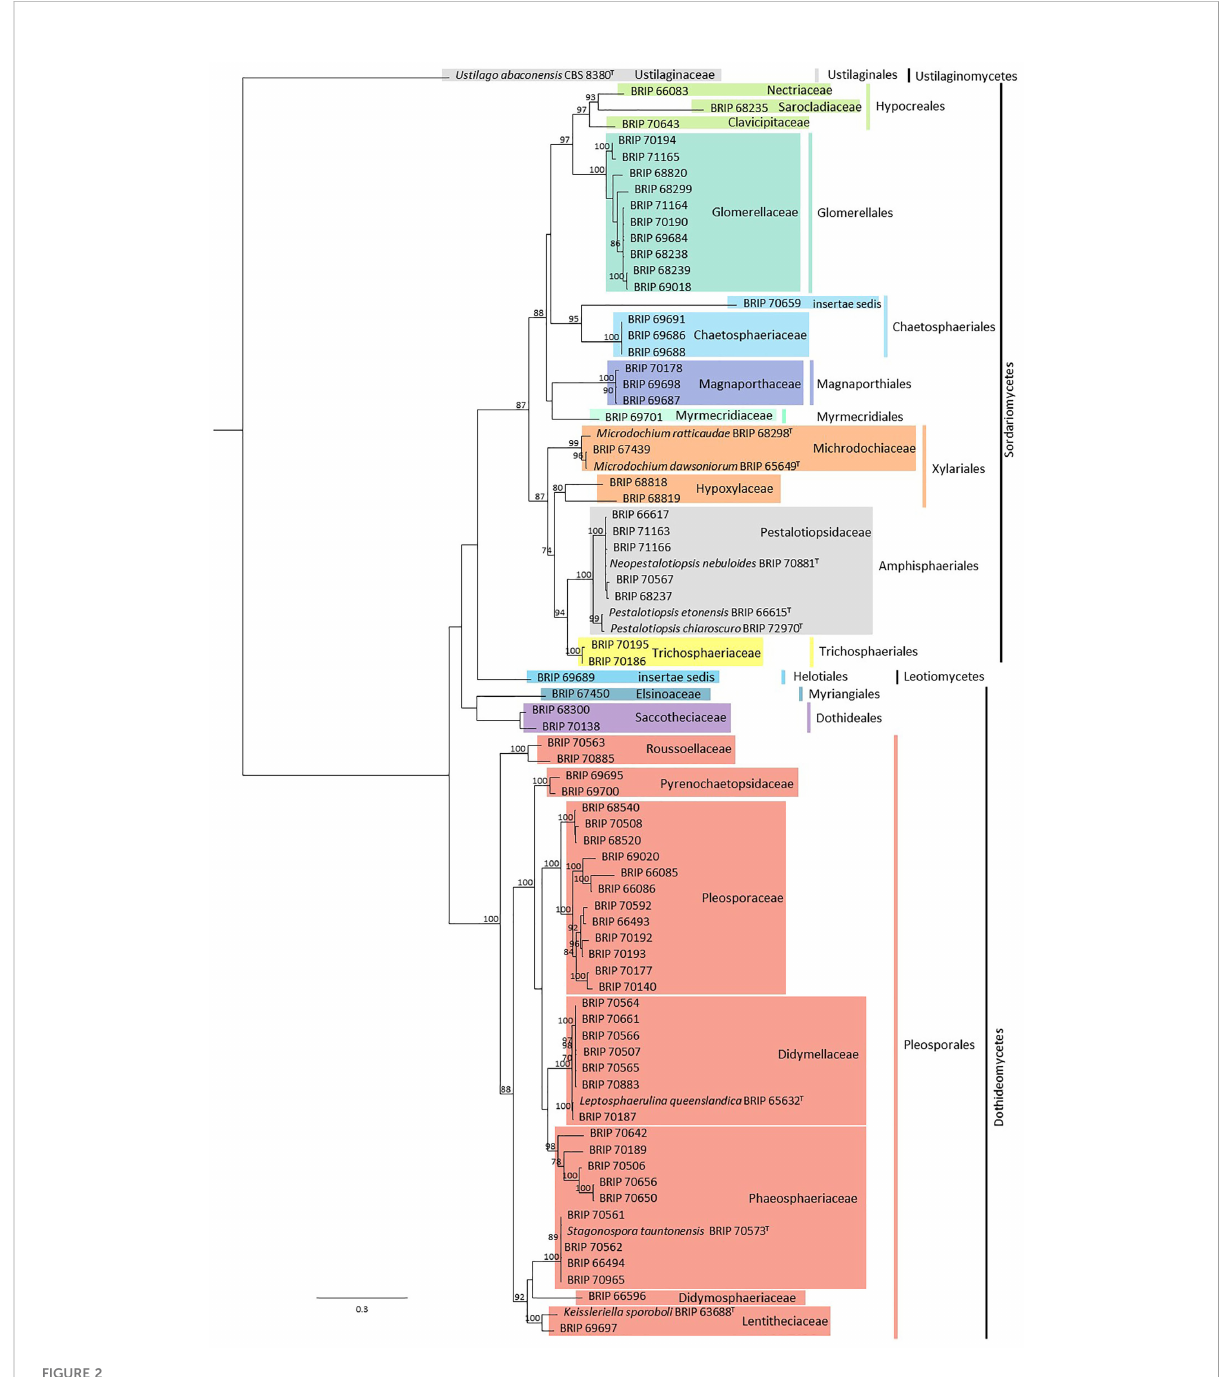
FIGURE 2 Phylogenetic tree inferred from a RAxML analysis based on a concatenated alignment of ITS and LSU sequences of the isolates in this study. RAxML bootstrap (bs) values greater than 70% are given at the nodes. In bold font are the isolates from this study and ex-type strains are indicated with T